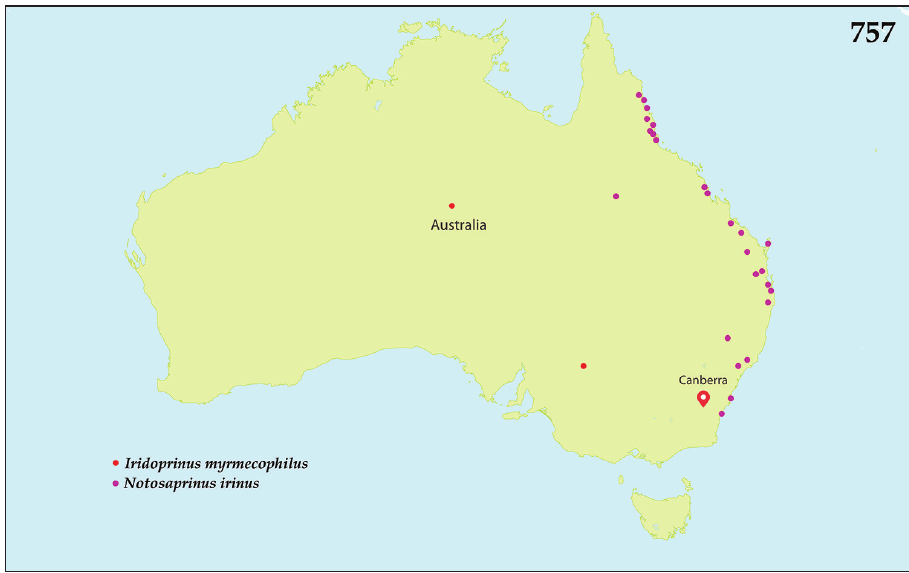
Figure 757. Distribution of Iridoprinus myrmecophilus gen. & sp. n. and Notosaprinus irinus (Marseul, 1862) in